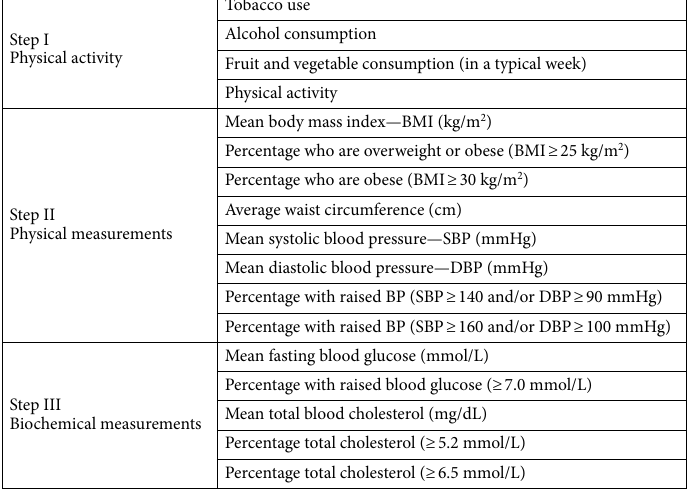
Table 2. Data gathered in each phase of the national STEPS project and the criteria observed in the survey analysis 41